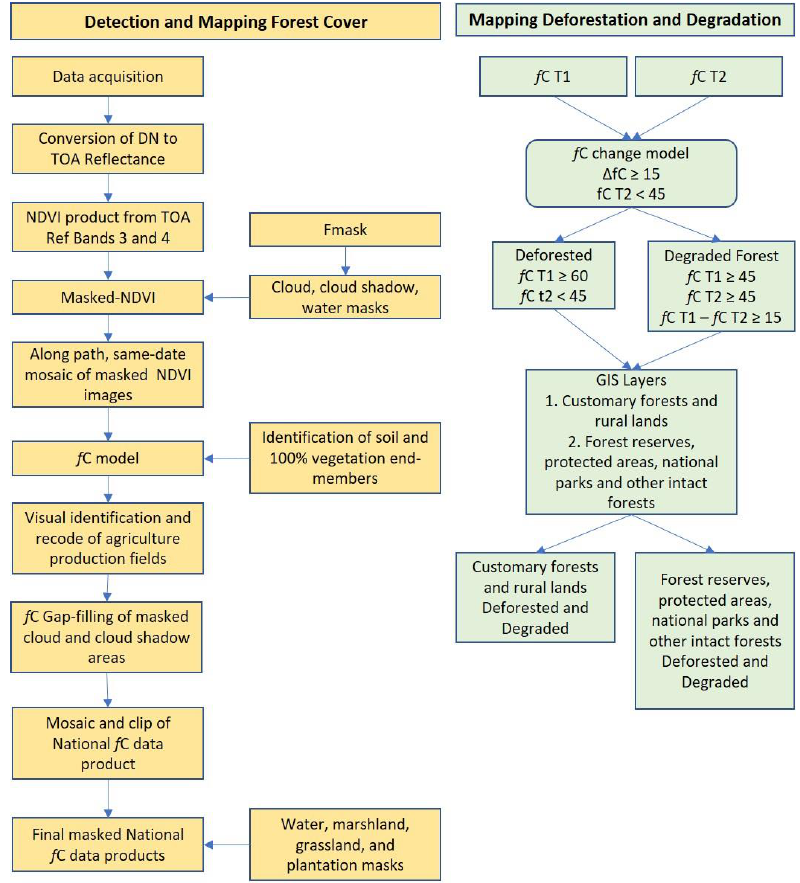
Figure A1. Data processing flow for developing the fC product .